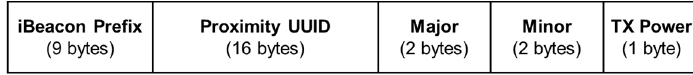
Figure 3. The breakdown of a Bluetooth low energy (BLE) air interface packet.